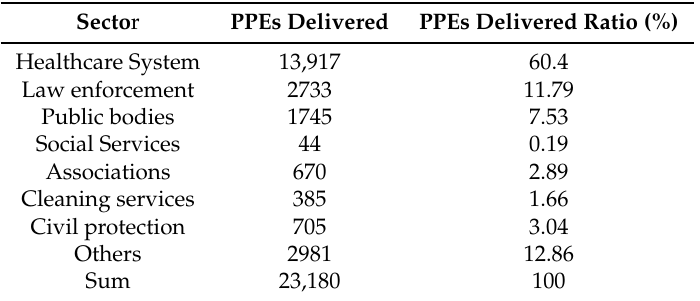
Table 9. Beneficiaries of 3D parts organized by sector.